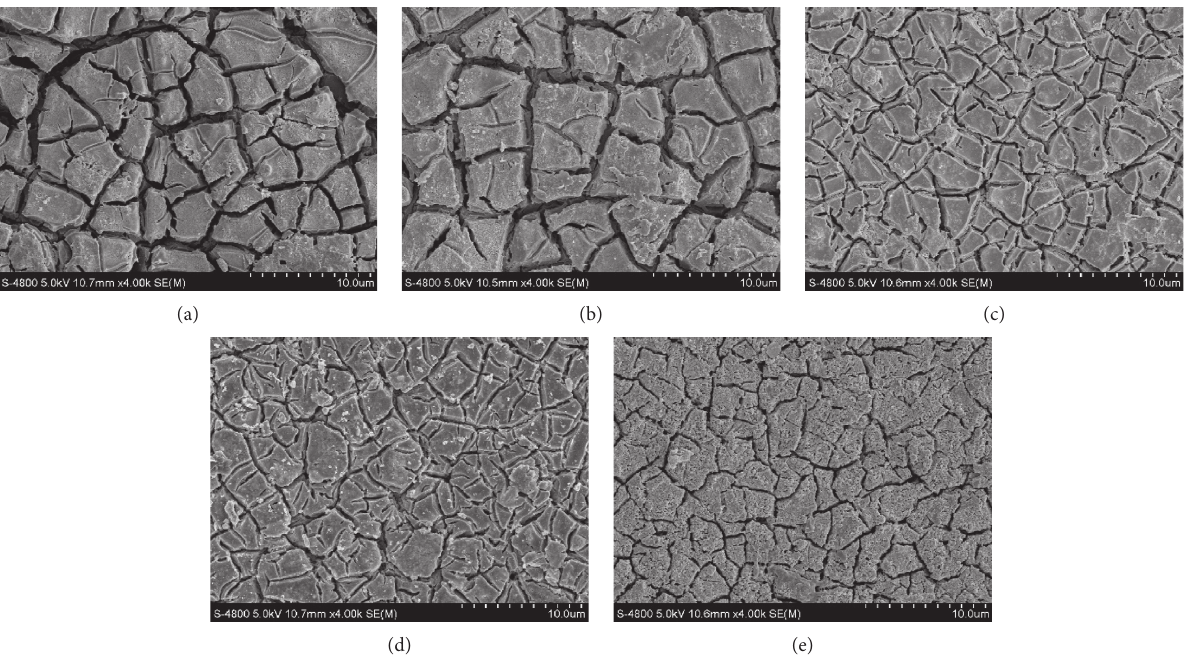
Figure 4: SEM images of Ti/SnO 2 -Sb-Ni/Er electrodes with (a) Ni (0%), (b) Ni (1%), (c) Ni (2%), (d) Ni (3.5%), and (e) Ni